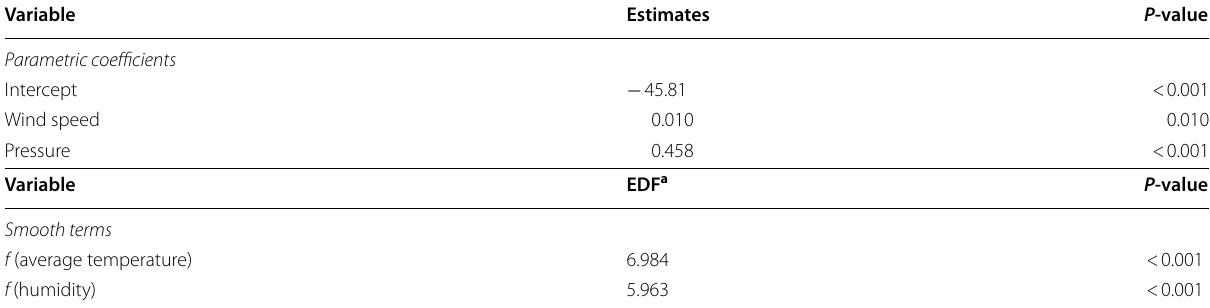
Table 2 Parameters’ estimate of the fitted GAM